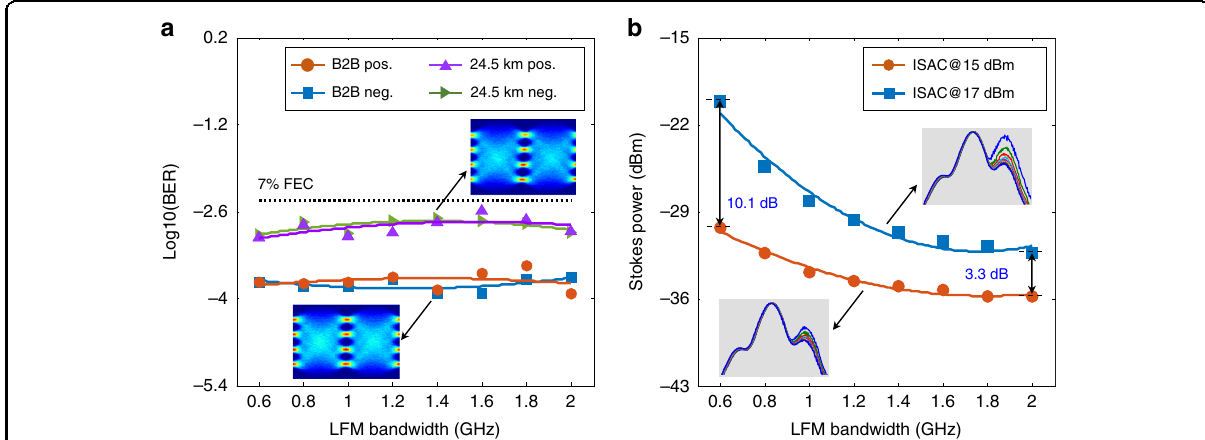
Fig. 4 The effect of LFM bandwidth on the BER performance. a BER performance of the PAM4 signal using positive (pos.) and negative (neg.) LFM optical carrier in the B2B test and 24.5 km fi bre transmission. b The power evolution of the backwards Stokes light with the increment of the LFM bandwidth. Here two different launching powers of 15 dBm and 17 dBm were